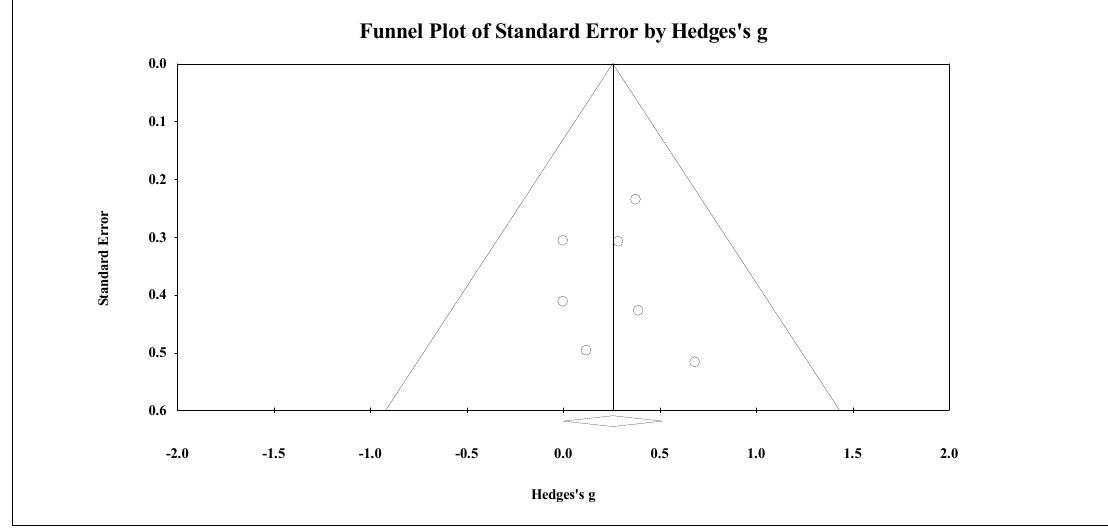
14 of 21 Figure 8. Forest plot of changes in lower-body bone mineral density in untrained adults after a training program based on soccer small-sided games (SSG) compared to controls. Values shown are effect sizes (Hedges’s g) with 95% confidence intervals (CI). The size of the plotted squares reflects the statistical weight of each study. The black diamond reflects the